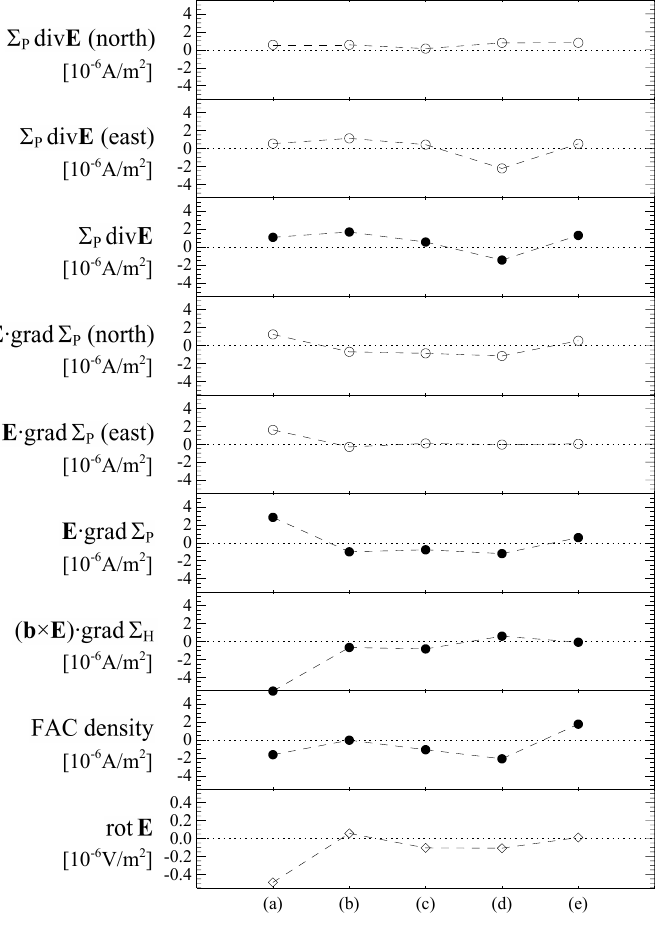
Fig. 7. Calculated FAC densities de- duced from EISCAT radar measure- ments. Each term (except the last term) of the formula (2), the total FAC den- sity, and rot E are plotted. Also, north- ward and eastward components of 6 P div E and E · grad 6 P are plotted. A positive value means an upward current